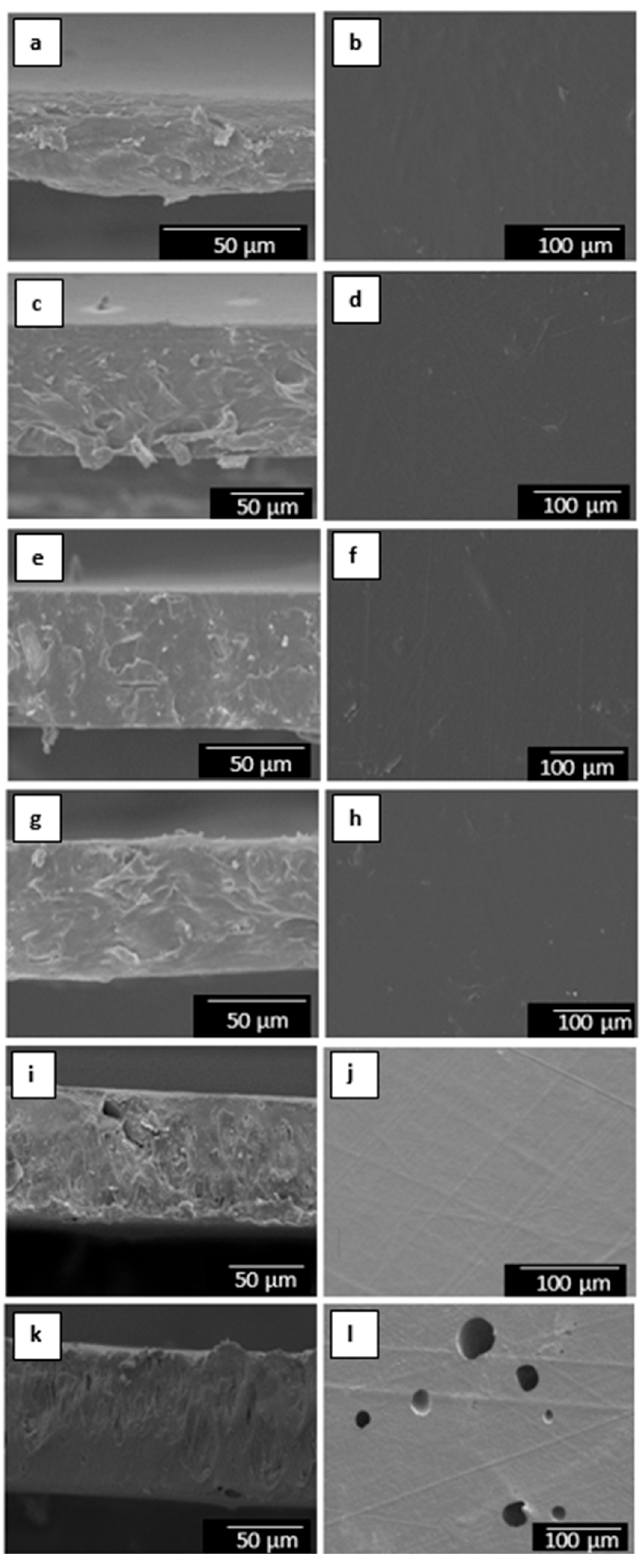
Figure 4. Scanning electron microscopy (SEM) images of the films cross-section (left) and top view (right) of poly(3-hydroxybutyrate- co -3-hydroxyvalerate) (PHBV)/Mobil Composition of Matter (MCM)-41 with eugenol: ( a , b ) 2.5 wt.-% MCM-41 + eugenol; ( c , d ) 5 wt.-% MCM-41 + eugenol; ( e , f ) 7.5 wt.-% MCM-41 + eugenol; ( g , h ) 10 wt.-% MCM-41 + eugenol; ( k , j ) 15 wt.-% MCM-41 + eugenol; ( k , l ) 20 wt.-% MCM-41 + eugenol. Scale markers of 50 µm and 100 µm.